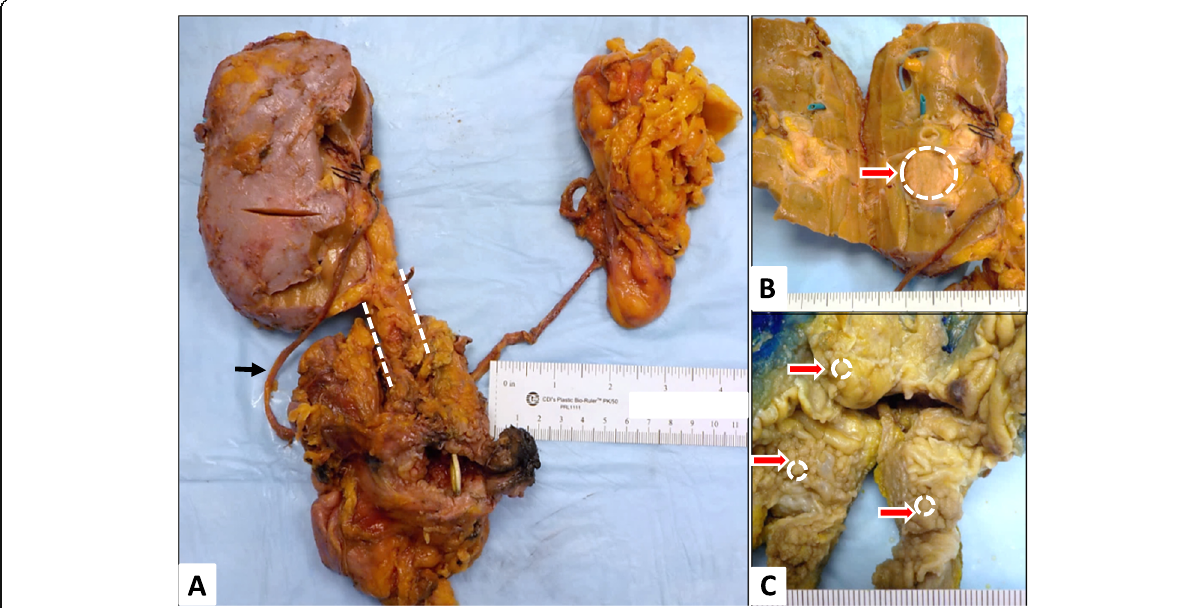
Fig. 1 A, Gross photograph of the nephro-cystectomy specimen shows the bladder, donor kidney (left side of image) with ureter (dash line), right native ureter (black arrow), and left native kidneys (right side of image); B, Donor kidney with a renal pelvic mass; C, Native bladder